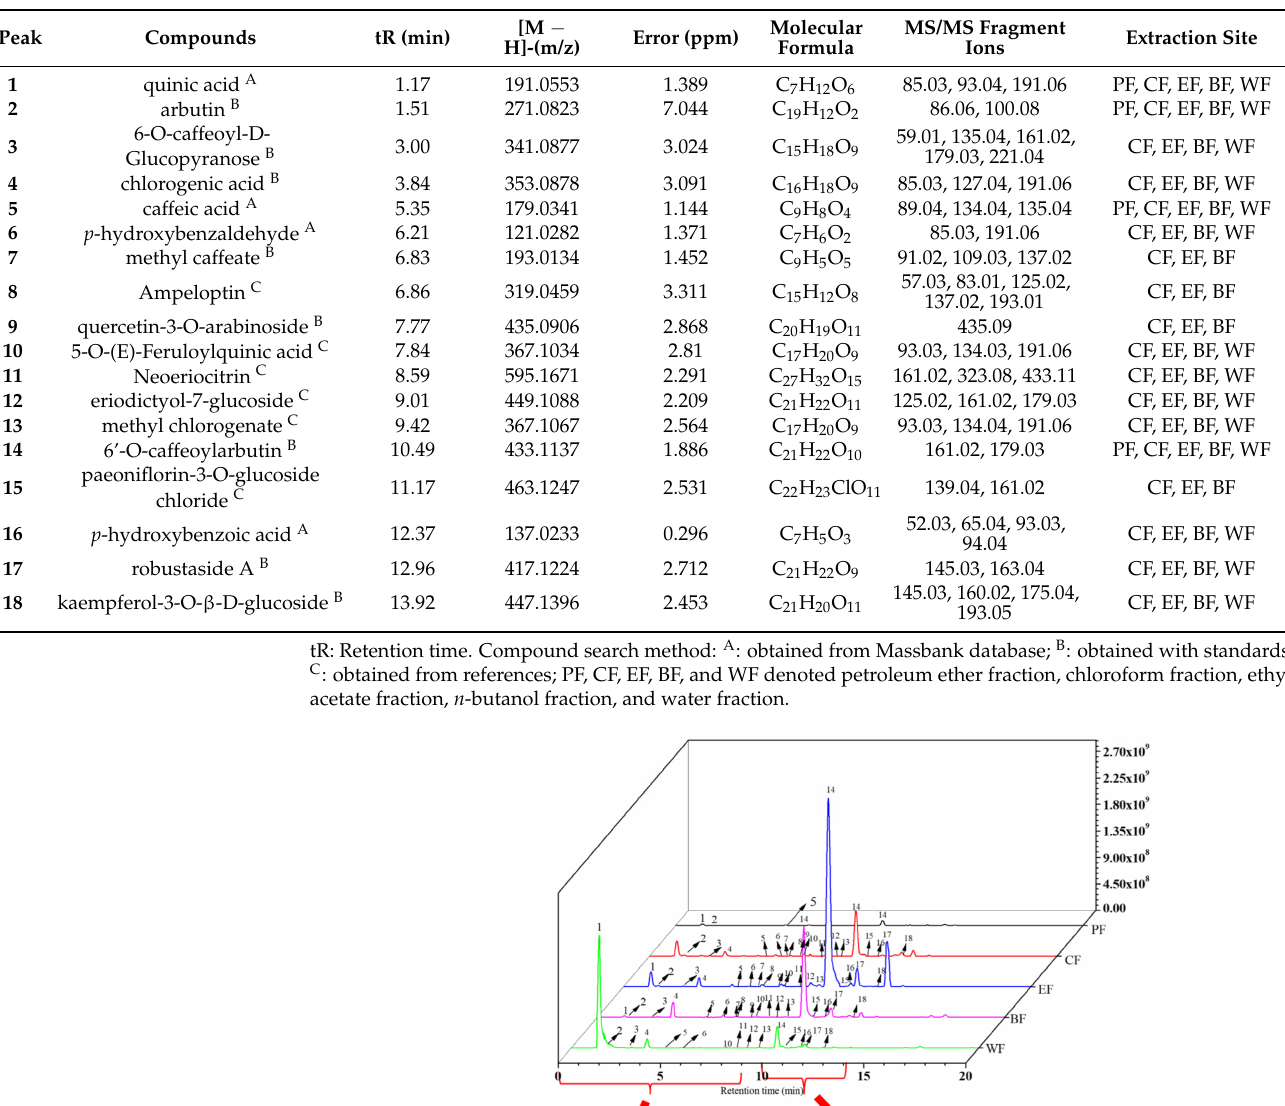
Table 2. Chemical composition of the five fractions from Vaccinium dunalianum using UHPLC- MS/MS in negative mode.